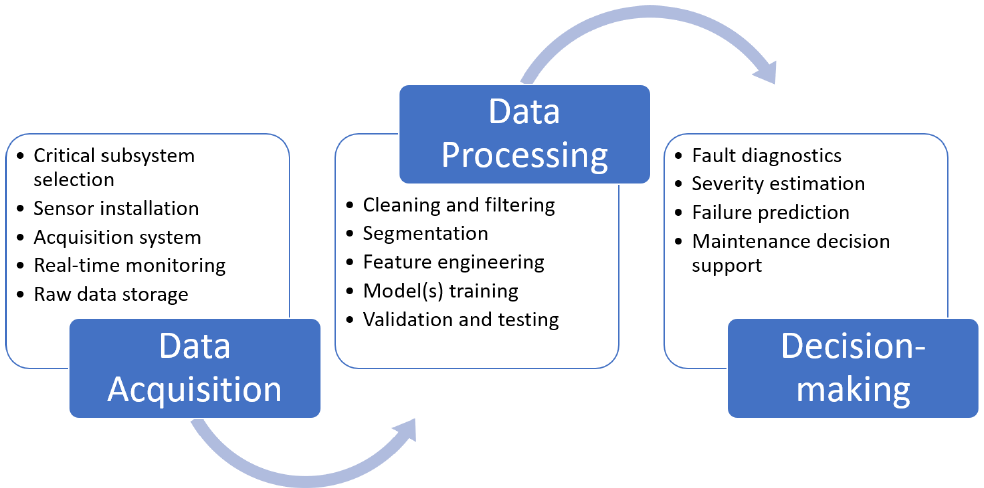
Figure 2. Implementation steps of CBM process for failure